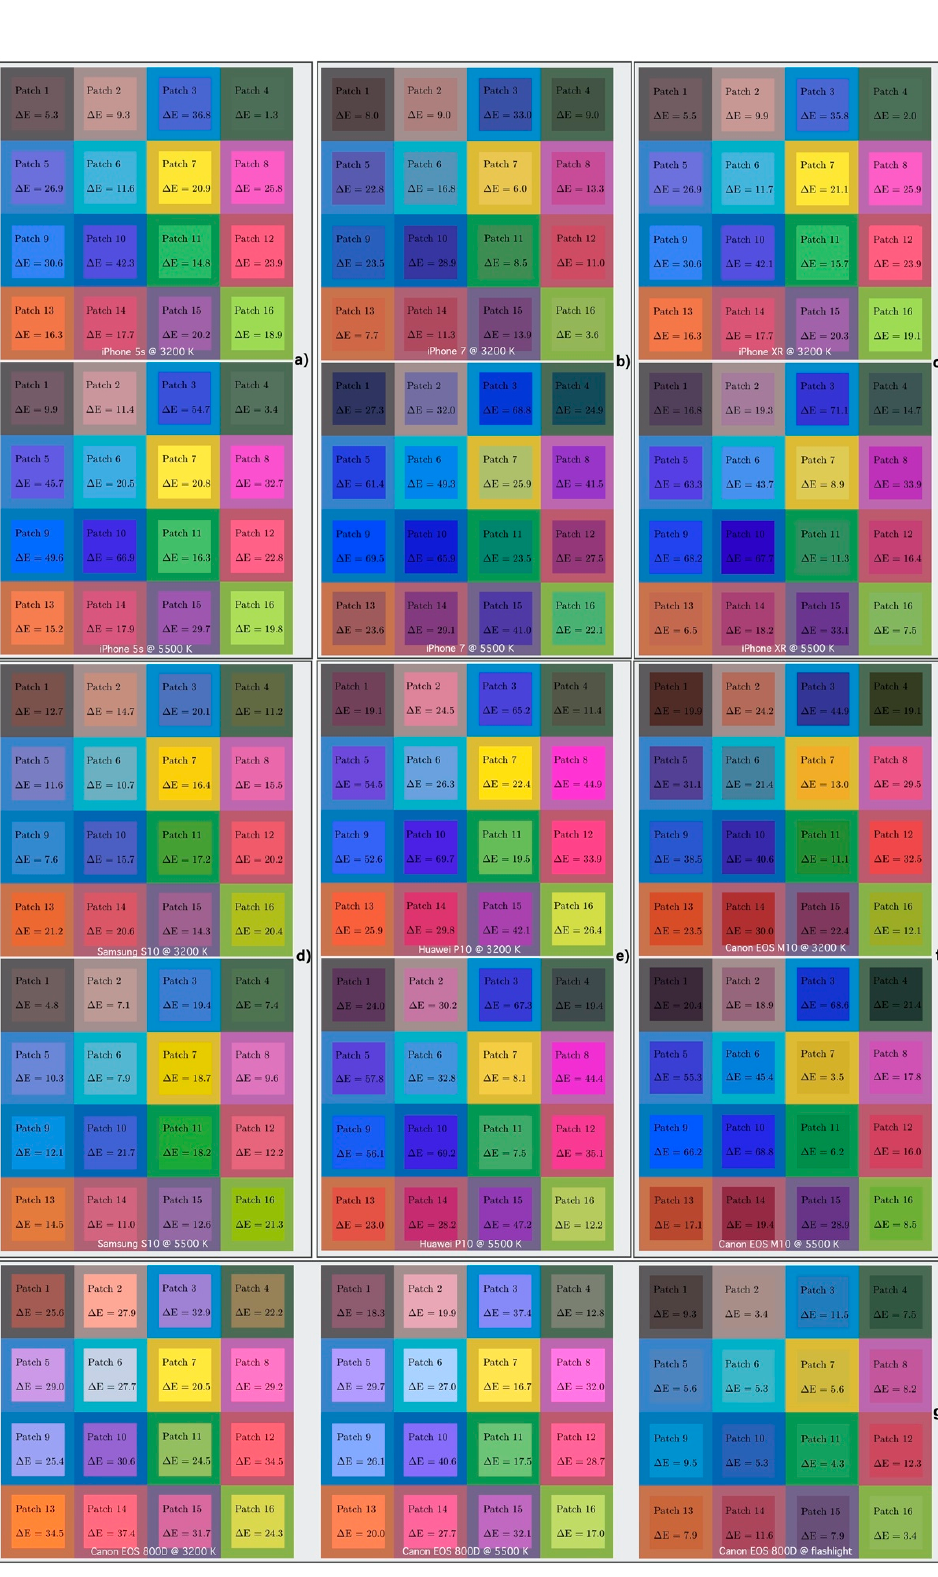
Figure 8. The colour difference between captured and reference colours from the test chart is measured and derived as the CIELAB Δ E colour distance. Diagrams for illuminance light source of 3200 K and 5500 K colour temperatures are presented, and for the Canon EOS 800D with the flashlight in the last row. Diagrams of captured colours are shown for the following devices: iPhone 5s ( a ), iPhone 7 ( b ), iPhone XR ( c ), Samsung S10 ( d ), Huawei P10 ( e ), Canon EOS M10 ( f ) and Canon EOS 800D ( g ).